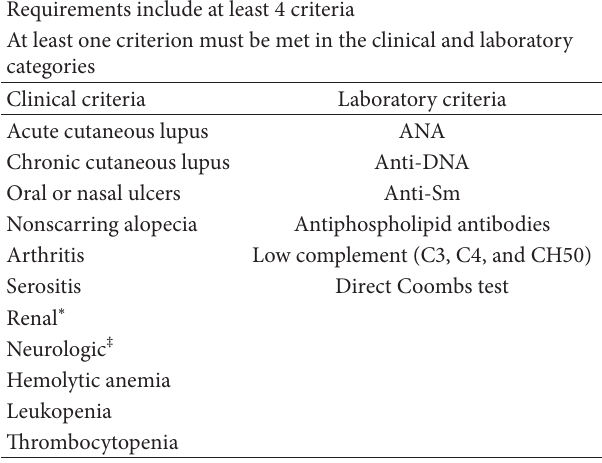
Table 1: Revised diagnostic criteria for systemic lupus erythemato- sus as defined by